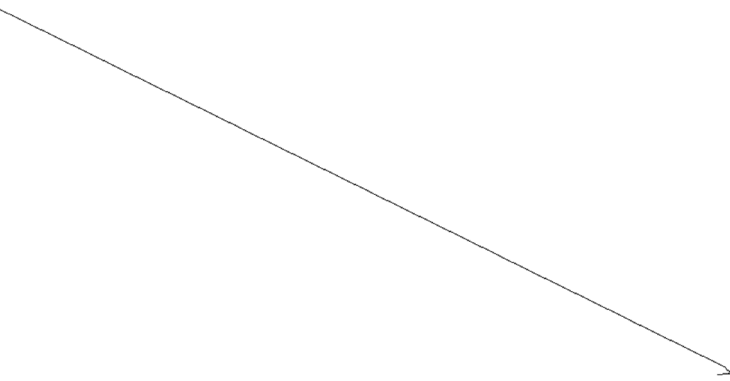
Figure 3. The linear trajectory of the particle in a two-dimensional chaotic model for the value of parameter p = 1.0.